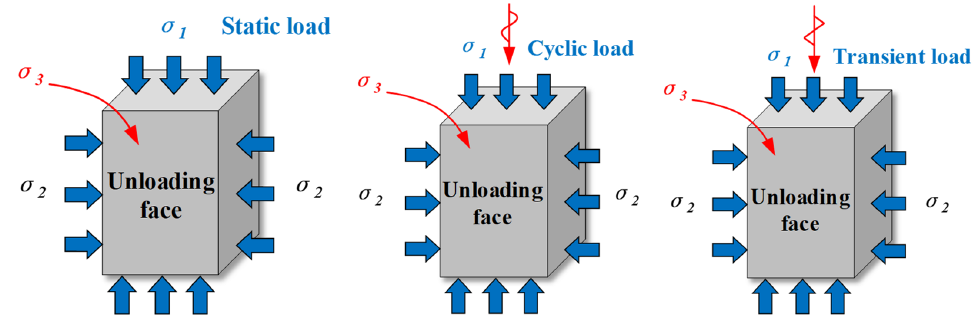
Figure 4. Different types of load disturbance.